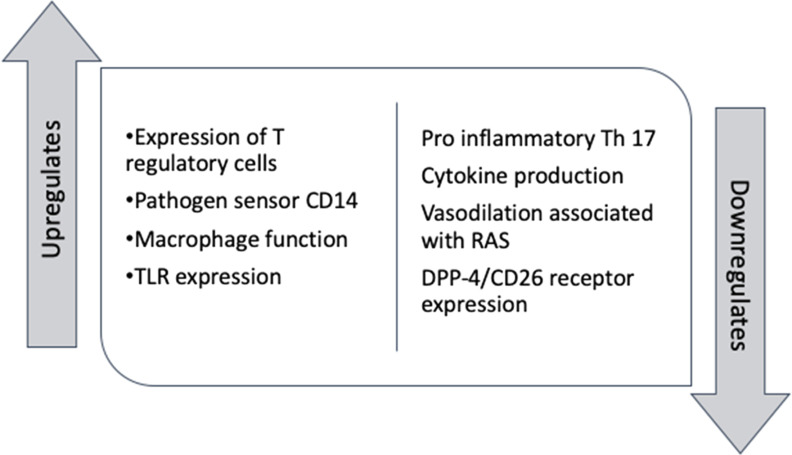
Mechanism of vitamin D anti-inflammatory and immunomodulatory function.